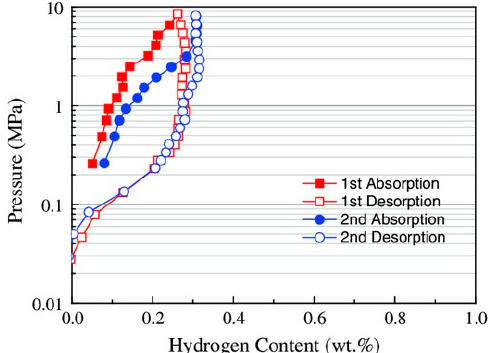
Figure 4. Hydrogen–pressure–composition isotherms at 673 K for high-entropy hydride MgTiVFeNi-H, synthesized by ball milling and high-pressure torsion for hydrogen storage, reproduced from [75], with permission from Wiley, 2020.